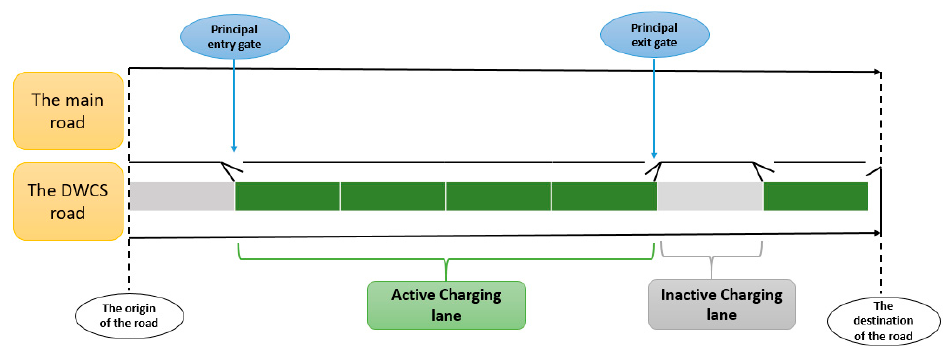
Figure 6. Highway with active and inactive charging